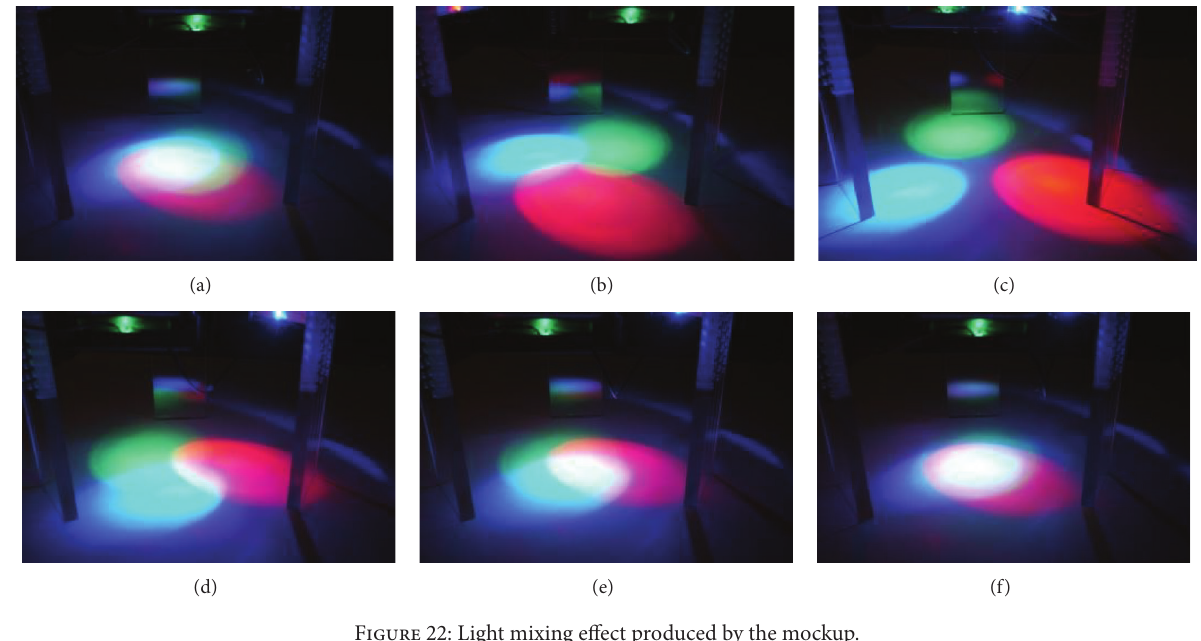
Figure 22: Light mixing effect produced by the mockup.